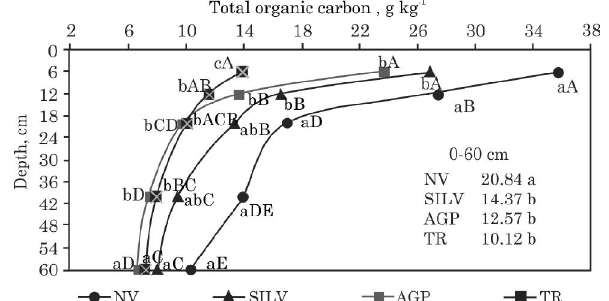
Figure 2. Soil total organic C contents in a typical Ortic Chromic Luvisol under natural vegetation (NV) and silvopastoral (SILV), agrosilvopastoral (AGP) and traditional agricultural (TR) systems after 13 years of soil cultivation in Sobral-CE. Means followed by the same letters do not differ by Tukey’s test at 5 %; uppercase letters compare soil depths in each management system and lowercase letters compare the management systems in each layer soil depth separately. The values in the figure represent the mean levels at all depths in each